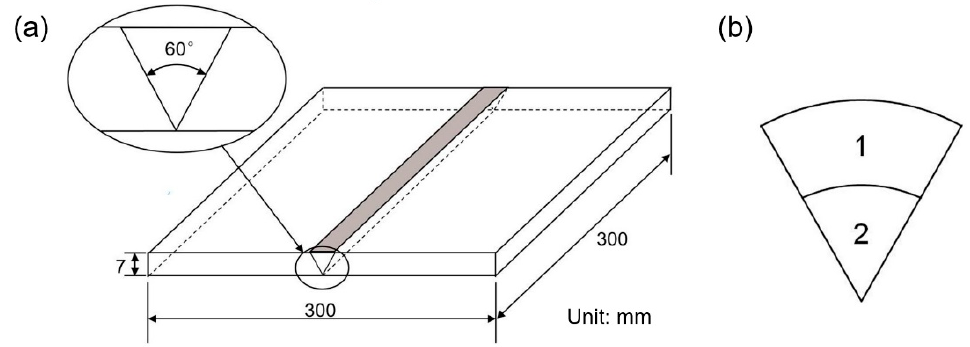
Figure 2. ( a ) Dimensions of welded joint and ( b ) pass arrangement.